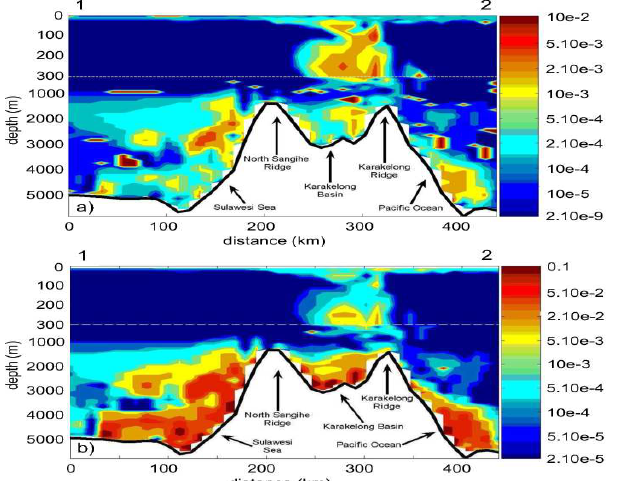
Fig. 4. Sections of (a) q 2 (m 2 s − 2 ) and (b) K M (m 2 s − 1 ) through the Lifamatola Sill. Locations of points 5 and 6 at the top of the figures are given in Fig. 1.